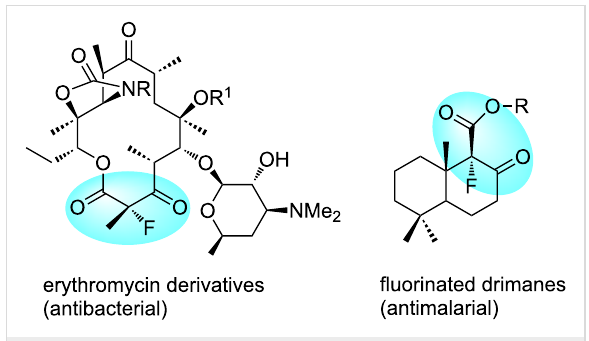
Figure 1: Biologically interesting α -fluorinated β